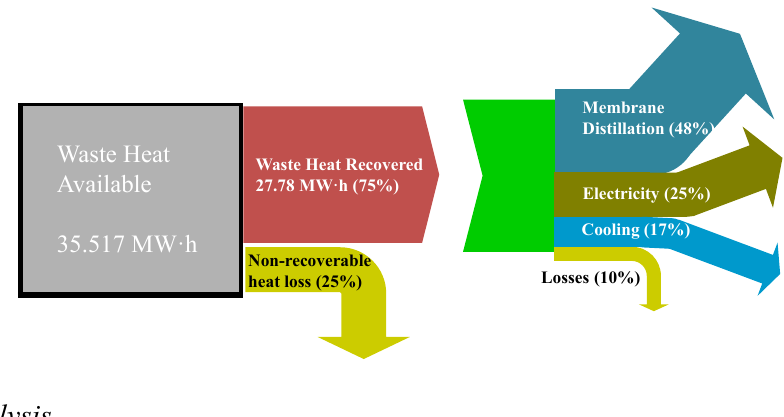
Figure 15. Sankey diagram of energy flows.